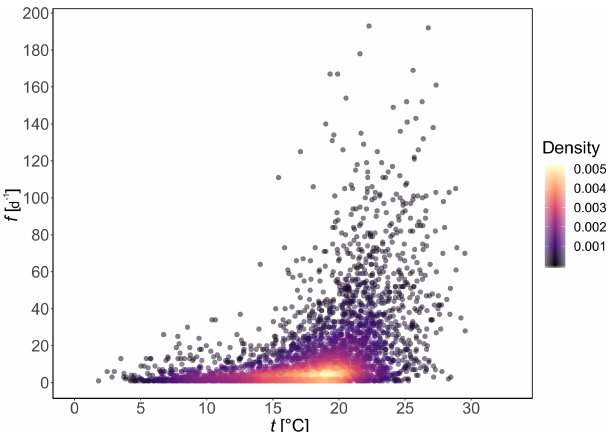
Figure 13. Scatterplot of temperature dependence on wildfire oc- currence in Porto District, Portugal, for the period 1980–2005, for those days where there are recorded both mean daily temperature ( t ) and at least one fire, with f the number of wildfires in 1d. Only those wildfires with burned area A F ≥ 0 . 1ha are included. Daily mean temperature data from E-OBS (Cornes et al., 2018) and wild- fire data from Pereira et al. (2011). Colours represent the bivariate density estimated from a kernel density